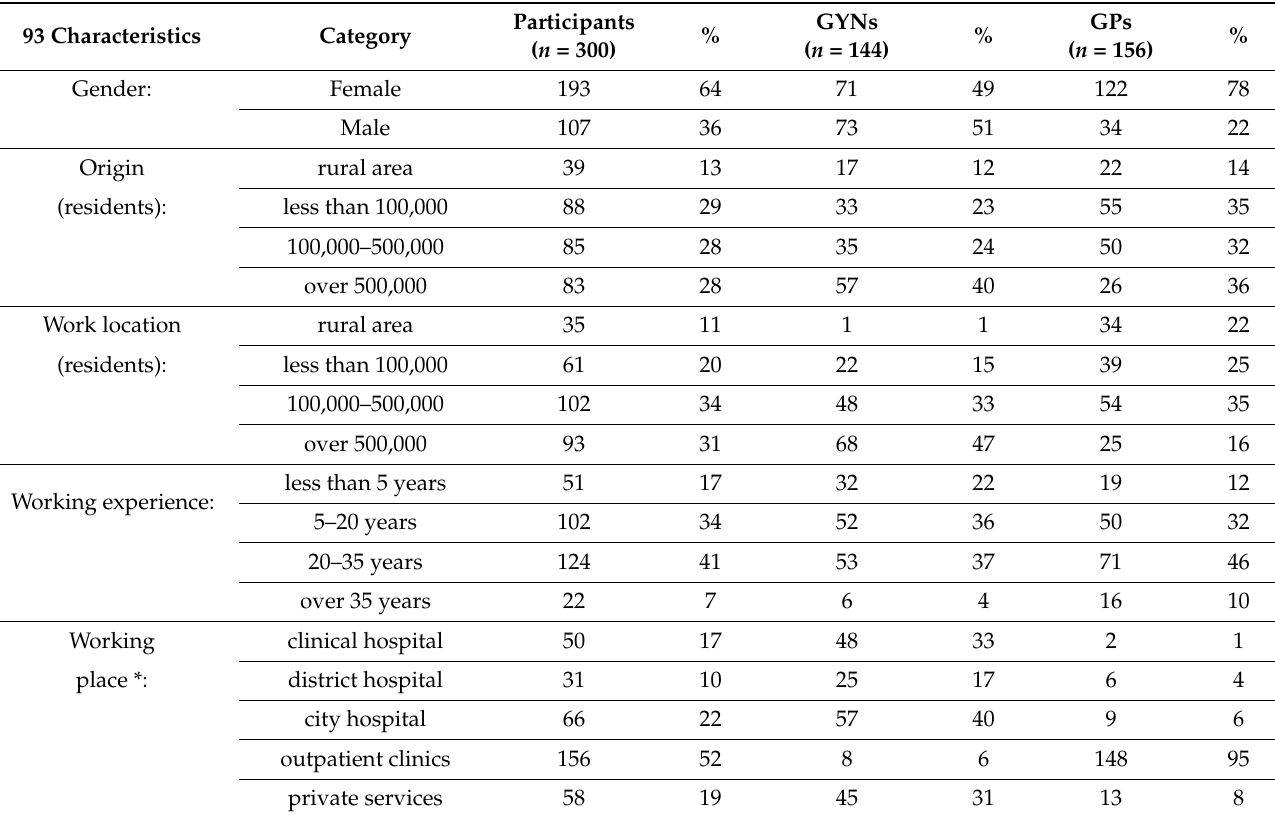
Table 1. Characteristics of Medical